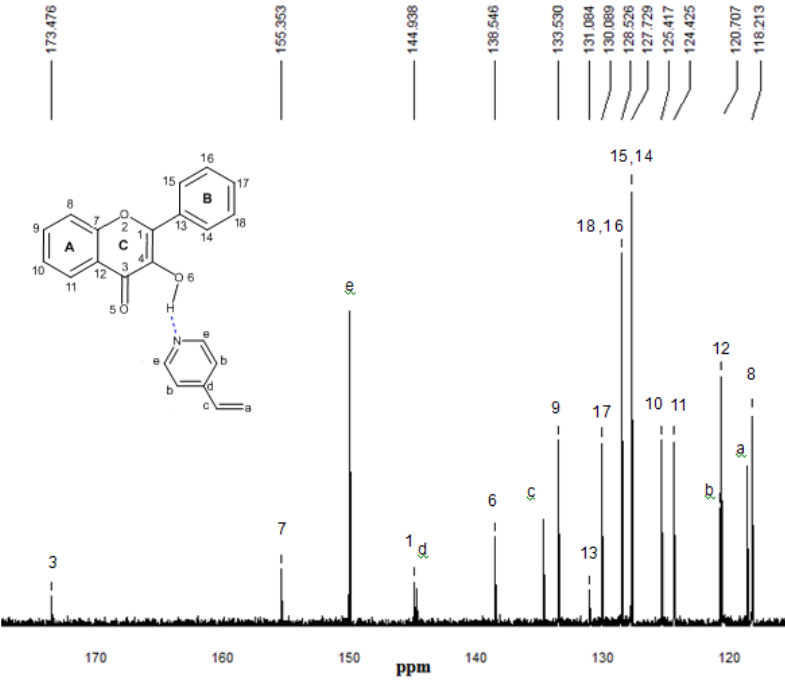
Figure 10. 13 C-NMR experimental spectrum of the complex FL-4VPy 1:1 in CDCl numbering that appears on each signal is relative to carbon